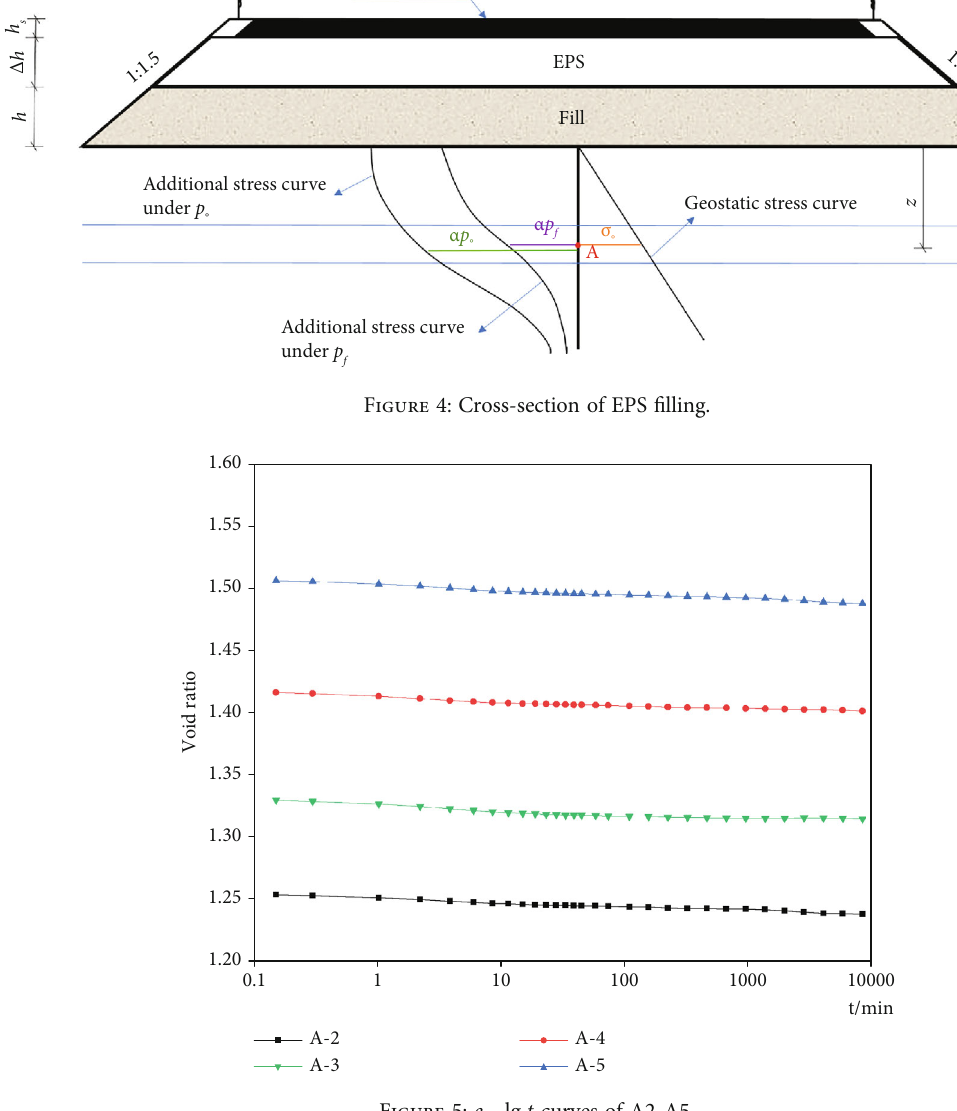
Figure 5: e − lg t curves of A2-A5.